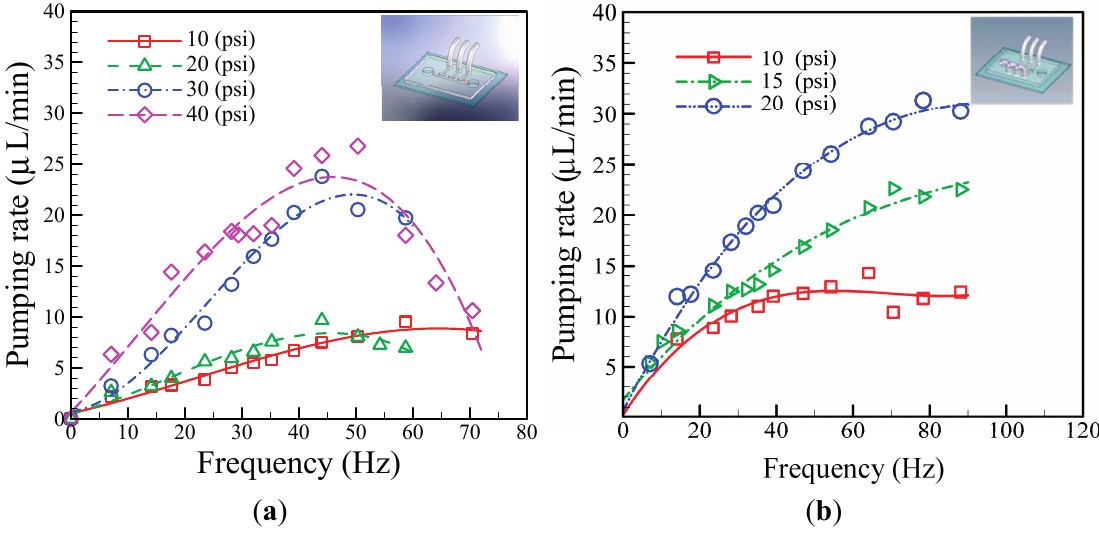
Figure 8. Relationship between the pumping rate and the driving frequencies at various operating air pressures. ( a ) the single-side; and ( b ) double-side actuated mode